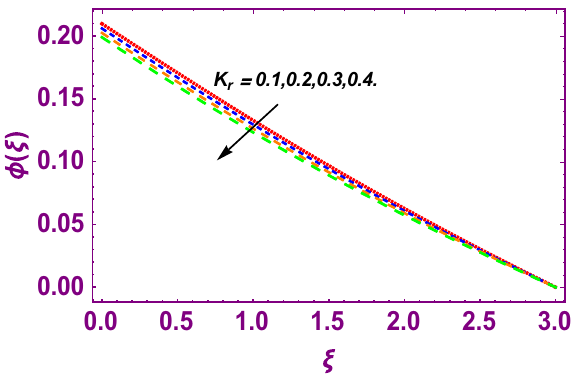
Figure 16. Effect of K r on φ(ξ) .